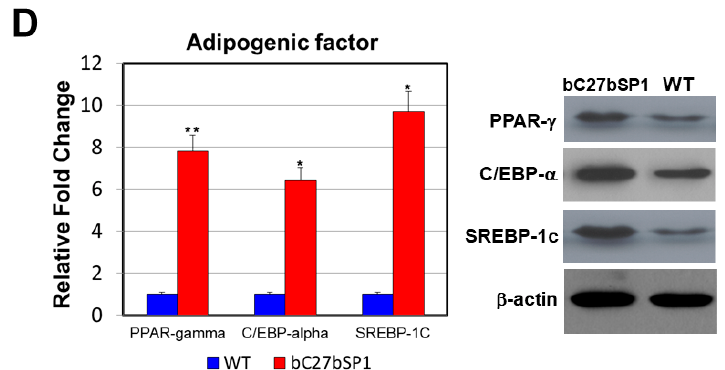
Figure 7. miR-27b depletion induces weight gain and increases fat mass in adult bC7aSPs. ( A ) bC27bSPs, hC27bSPs and WT were fed a HFD for 210 days. Serial body weight of each zebrafish was monitored monthly ( n = 20–25). * p < 0.01, and ** p < 0.005. ( B ) Representative images of male and female bC27bSP1 and WT fed either a HFD for five months. ( C ) miR-27b depletion leads to greater abdominal fat (left), larger internal organs (middle) and the increased intra-abdominal fat pad size is shown (right). Adipose tissues are circled. 40 × magnification, scale bars: 25 mm ( D ) Expression of adipogenic genes and proteins in abdominal fat of WT and bC27bSP1. PPAR- γ , C/EBP- β , and SREBP-1c mRNA (left, qRT-PCR) and proteins (right, western blot). * p < 0.01, and ** p < 0.005.